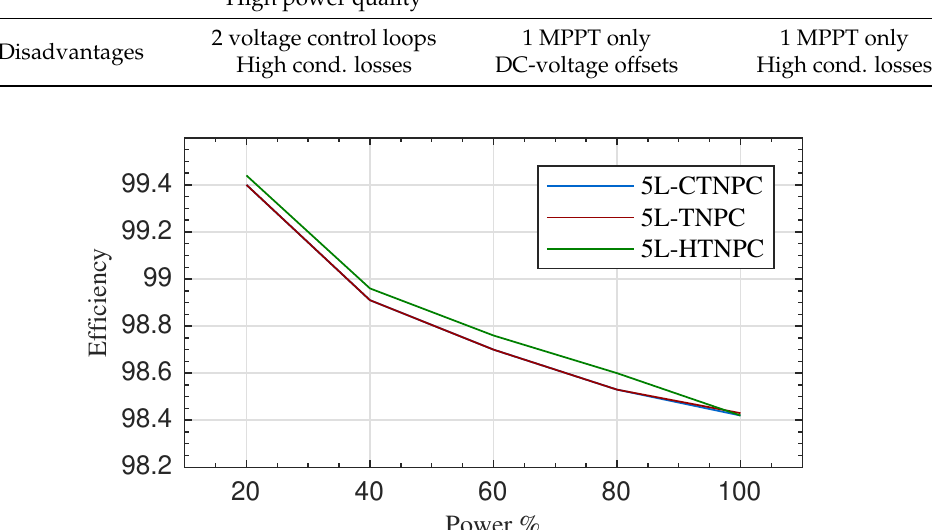
Figure 17. Efficiency comparison between 5L-CTNPC, 5L-HTNPC and 5L-TNPC inverter topologies respect to the power